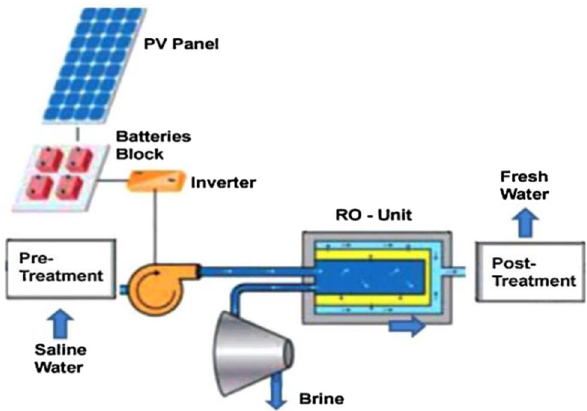
Fig. 29 The combination of a reverse osmosis system with photovol- taic (NREL